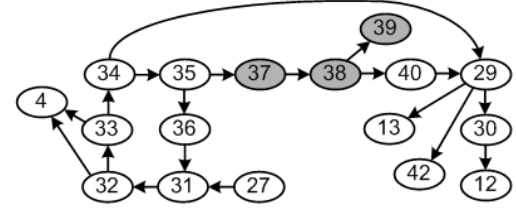
Fig. 4. Topological space part that represents detailed functionality of payment